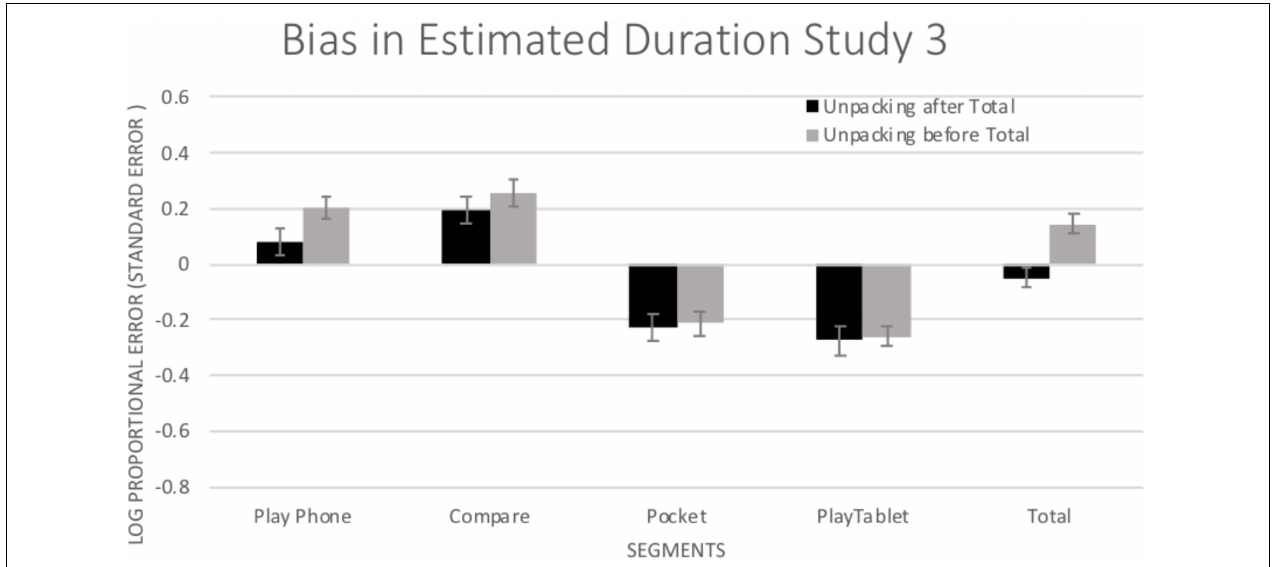
FIGURE 5 | Mean ( ± 1 SE ) bias in estimated duration (log of estimated duration/actual duration) for all of the segments of the crime. Positive values indicate overestimation and negative values indicate underestimation.